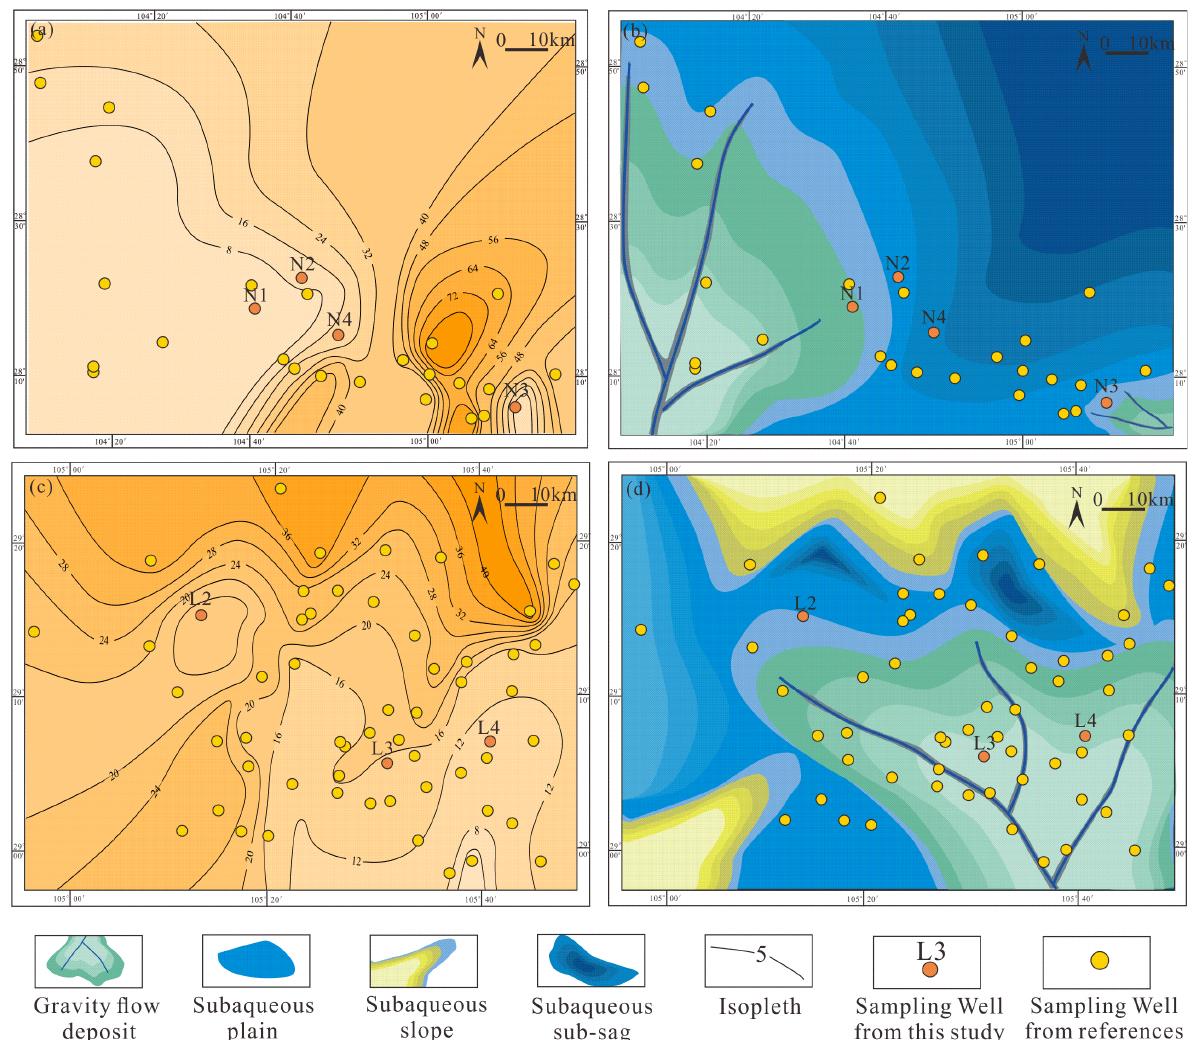
Figure 5. Distribution of average resistivity and sedimentary microfacies of Wufeng-L1 14 layer at the Changning block and Luzhou block. ( a ) Resistivity at the Changning block, ( b ) sedimentary microfacies at the Changning block, ( c ) resistivity at the Luzhou block, ( d ) sedimentary microfacies at the Luzhou block.